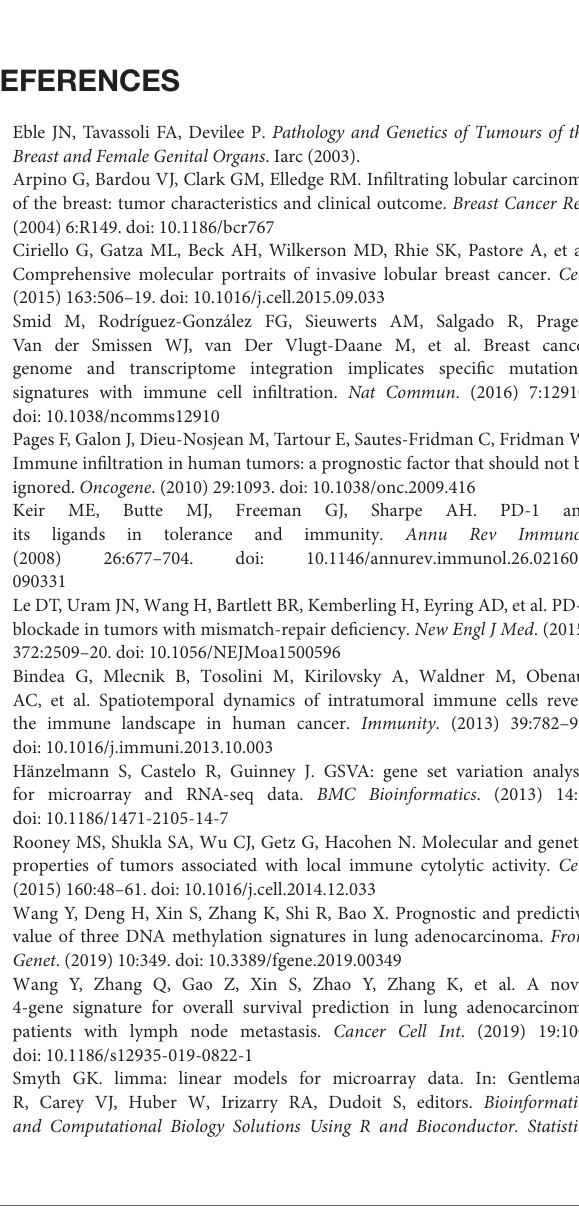
Figure S4 | The correlation between the expression of seven genes in the immune signature and the RFS probability of IDC patients. (A) BATF, (B) KLRB1, (C) TIMM8A, (D) FLT3LG, (E) QRSL1, (F) IGHA1, (G) SPIB. Figure S5 | Validation of the immune signature in two external cohorts, GSE20685 (A) and GSE86948 (B) . Figure S6 | The correlation between the ssGSEA scores of DCs and the OS probability of IDC patients in the high- and low-risk score groups. (A) The ssGSEA scores were higher in the high- and low-risk score groups. (B) The correlation between the ssGSEA scores of DCs and the OS probability of IDC patients in the low-risk score group. (C) The correlation between the ssGSEA scores of DCs and the OS probability of IDC patients in the high-risk score group. Figure S7 | The correlation between the ssGSEA scores of MDSCs and the OS probability of IDC patients in the high- and low-risk score groups. (A) The correlation between MDSC ssGSEA scores and risk scores. (B) The correlation between the ssGSEA scores of DCs and the OS probability of IDC patients in the whole cohort. (C) The correlation between the ssGSEA scores of DCs and the OS probability of IDC patients in the low-risk score group. (D) The correlation between